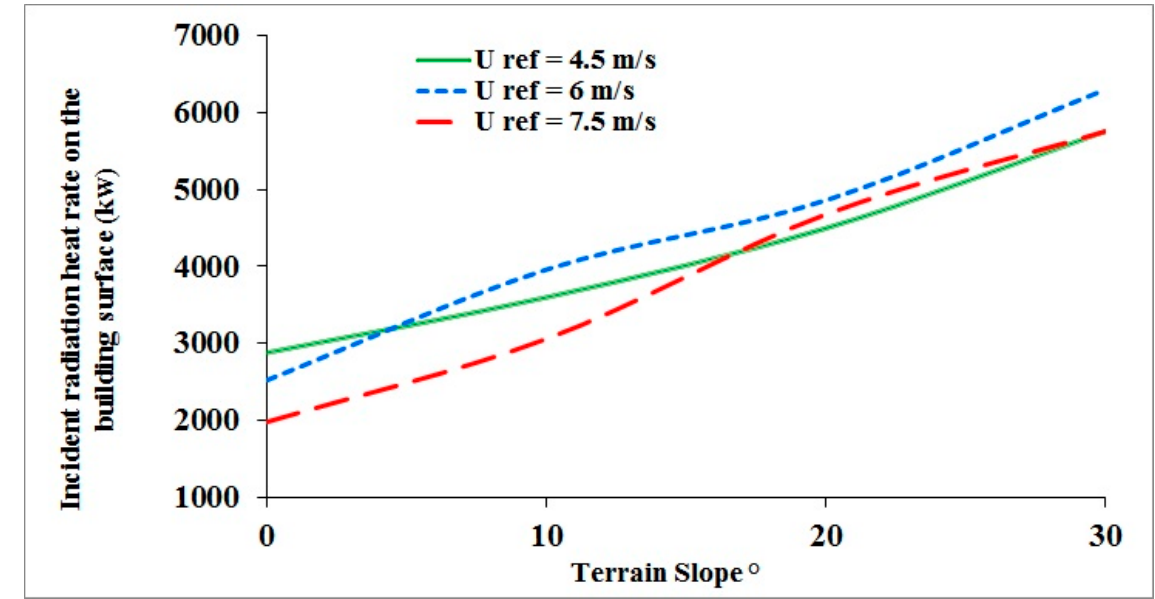
Figure 4. Incident radiation heat rate on the building surface for U ref = 4.5, 6, and 7.5 m/s and terrain slope 0°, 10°, 20°, and 30°.